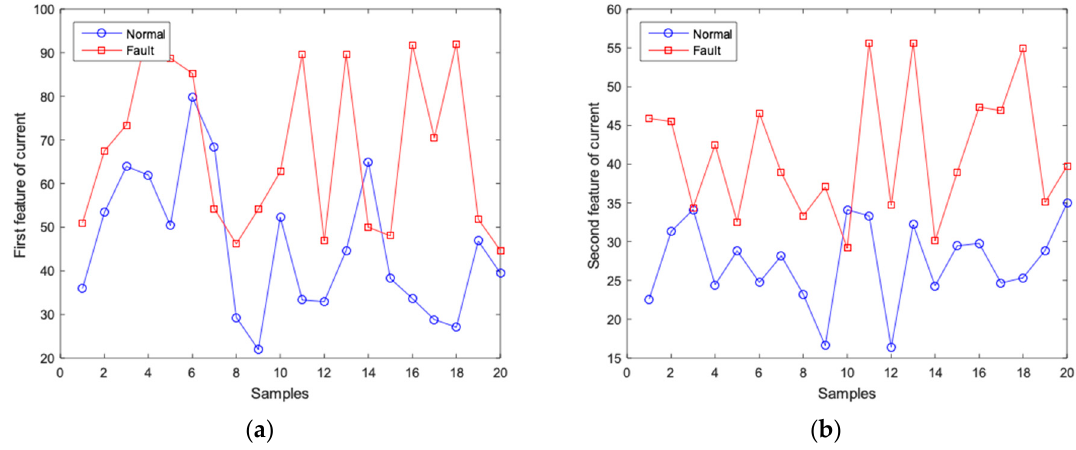
Figure 10. Features extracted from the current signals ( a ) First feature of current; ( b ) Second feature of current.